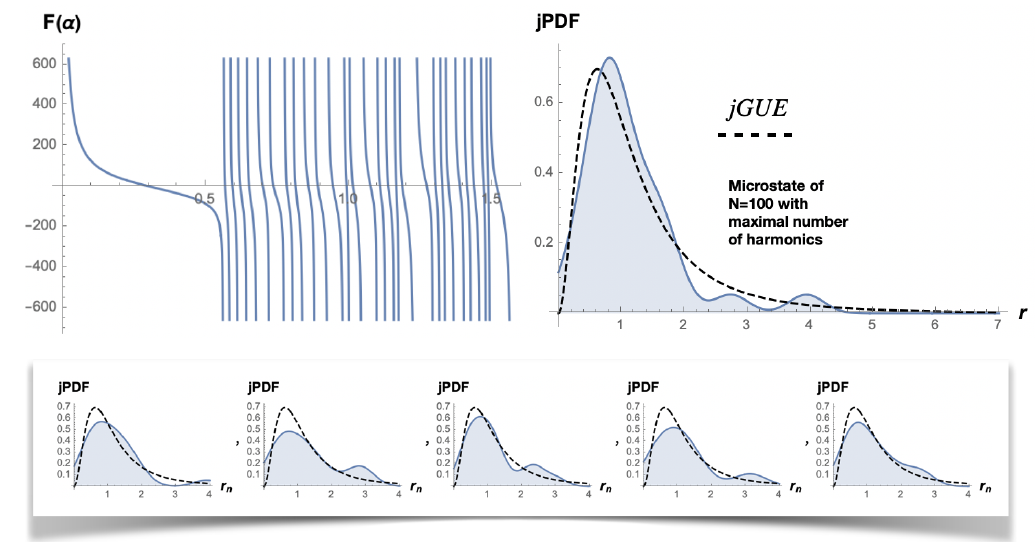
Figure 4 . Microstates of N = 100 . From left to right the profile of the logarithmic derivative of the decay amplitude and the joint probability distribution both relative to the microstate with maximal number of harmonics. The dashed line is the joint probability distribution with β = 2 , which represents the joint GUE distribution (jGUE). Below there are five examples of joint probability distributions for microstates with less number of harmonics.